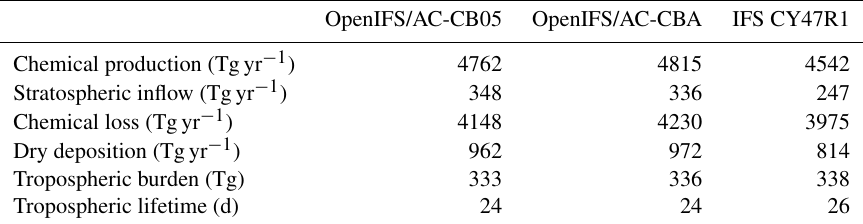
Table 5. Tropospheric ozone budget. The stratospheric inflow is calculated as the sum of the deposition and the tropospheric chemical loss minus production. Also included are results from IFS CY47R1 (Williams et al., 2021) for the year 2014, for